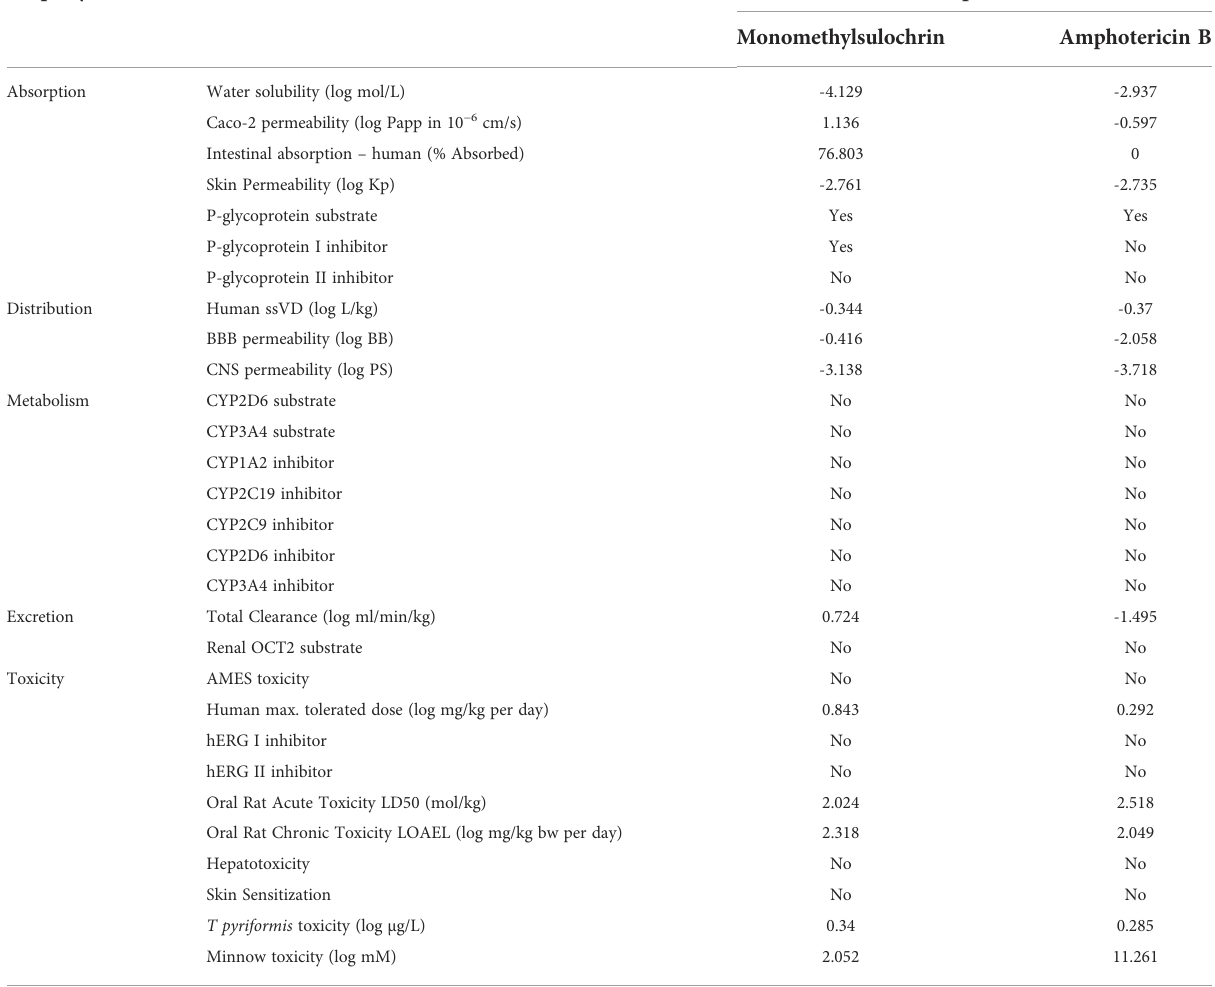
TABLE 3 In silico pharmacokinetics and toxicity properties of monomethylsulochrin compound and amphotericin